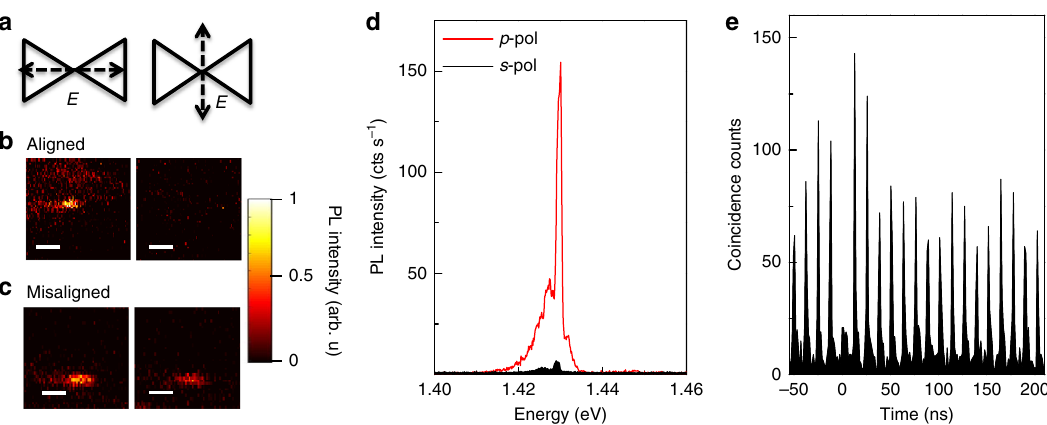
Fig. 3 Polarization dependence and quantum light signature of exciton emission. a Schematic of excitation laser with linear polarization set to be either parallel ( p -pol, left) or perpendicular ( s -pol, right) to the long axis of bowtie dimer. b Photoluminescence (PL) maps of individual SWCNT that are well- aligned along the dimer axis for both p -pol (left) and s -pol (right) excitation. c Similarly recorded polarization-dependent PL maps for a SWCNT that is orientationally misaligned. Scale bars are 1 μ m. d Corresponding PL spectra for a well-aligned SWCNT featuring a large excitation polarization extinction ratio of 25:1. e Second-order correlation function g (2) ( τ ) recorded at P exc = 200 μ W excitation power demonstrating pronounced single photon antibunching with g (2) (0) = 0.30 ±